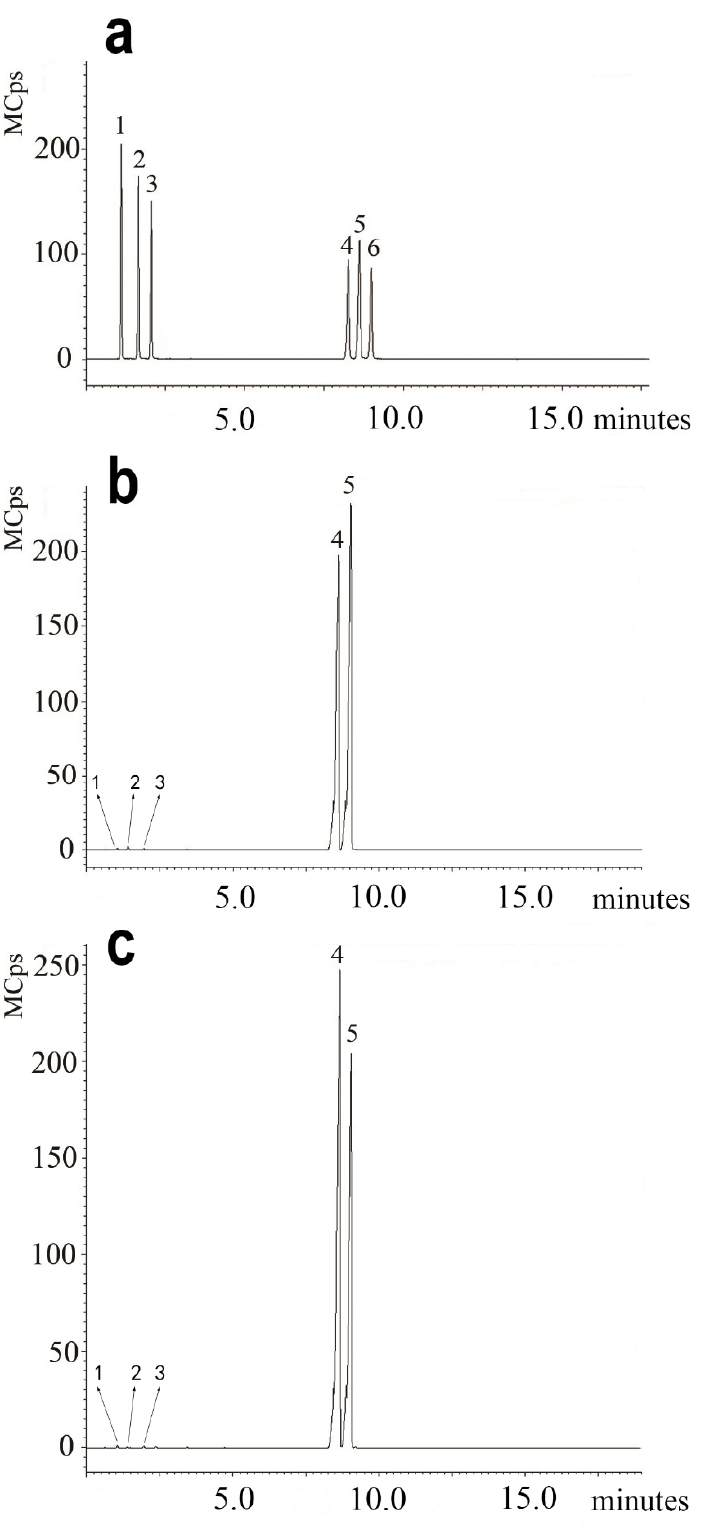
Figure 5. Monosaccharide standard and monosaccharide components of the FDOP and DDOP were analyzed by GC-MS. Mixed standard solutions of monosaccharides ( a ) (rhamnose, aldose, xylose, mannose, glucose and galactose in the sequence from left to right 1–6); FDOP samples ( b ); DDOP samples ( c ).